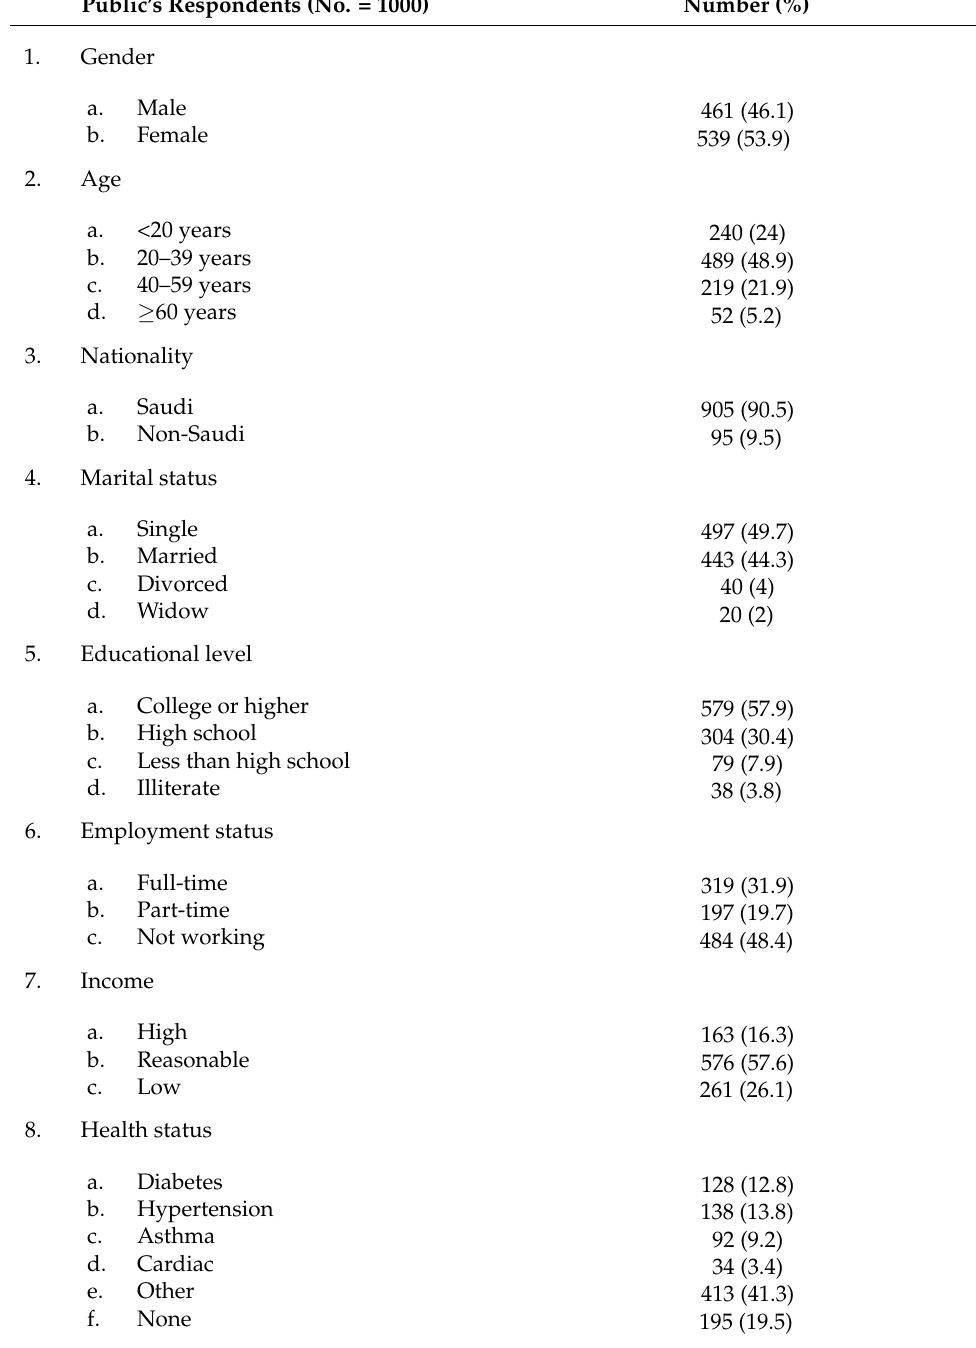
Table 1. Demographic Characteristics of Study